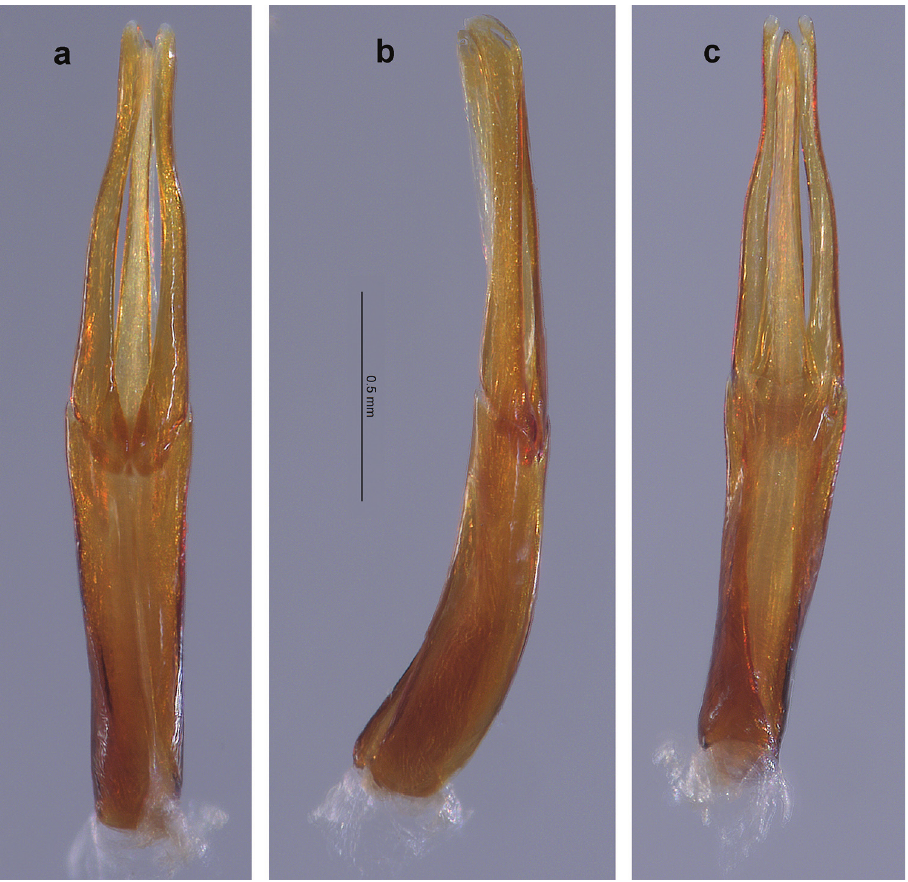
Figure 2. Amazonopsis theranyi sp. n., male genitalia of holotype from Peru a Dorsal view b Lateral view c Ventral